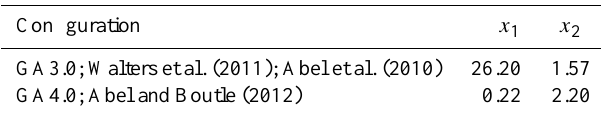
Table 2. Changes to the rain particle size distribution parameters between GA3.0 and GA4.0.